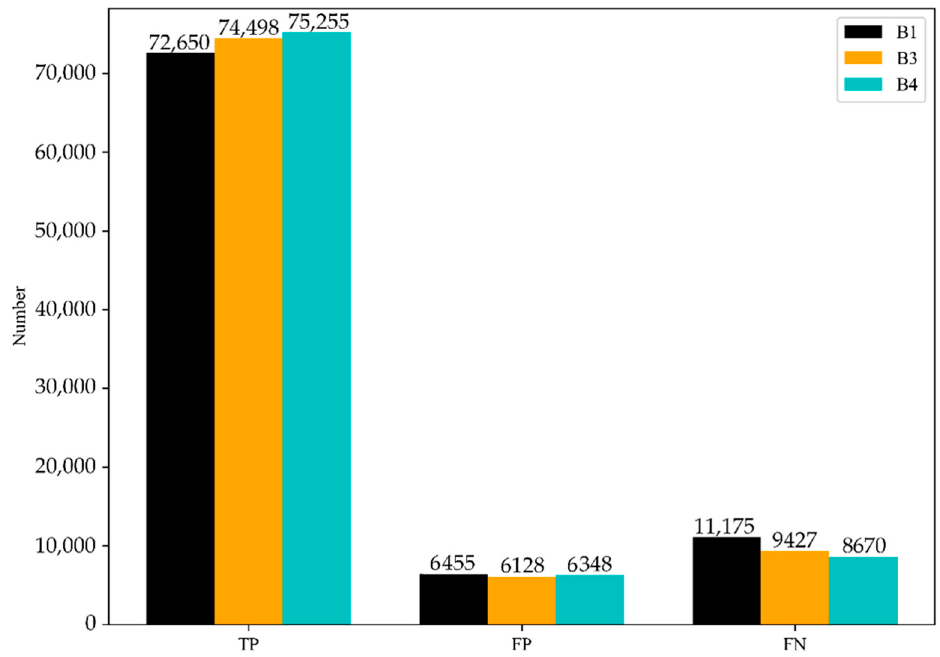
Figure 11. The number of TPs, FPs, and FNs in B1, B3, and B4 scenarios for AFD by MultiScale-Net.